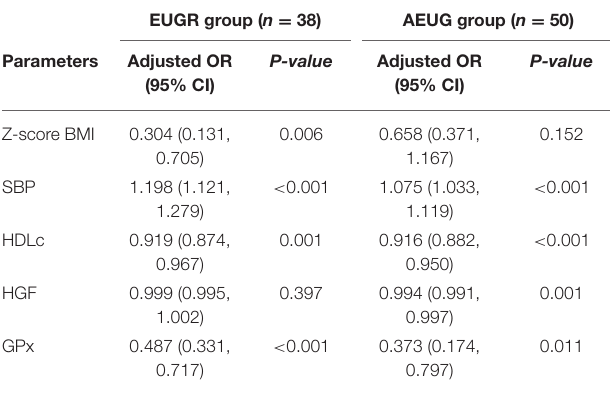
TABLE 6 | Multiple logistic regression analysis in the BIORICA study to identify variables in prepubertal children associated with the condition of prematurity within the extrauterine growth restriction (EUGR) group and with adequate extrauterine growth (AEUG